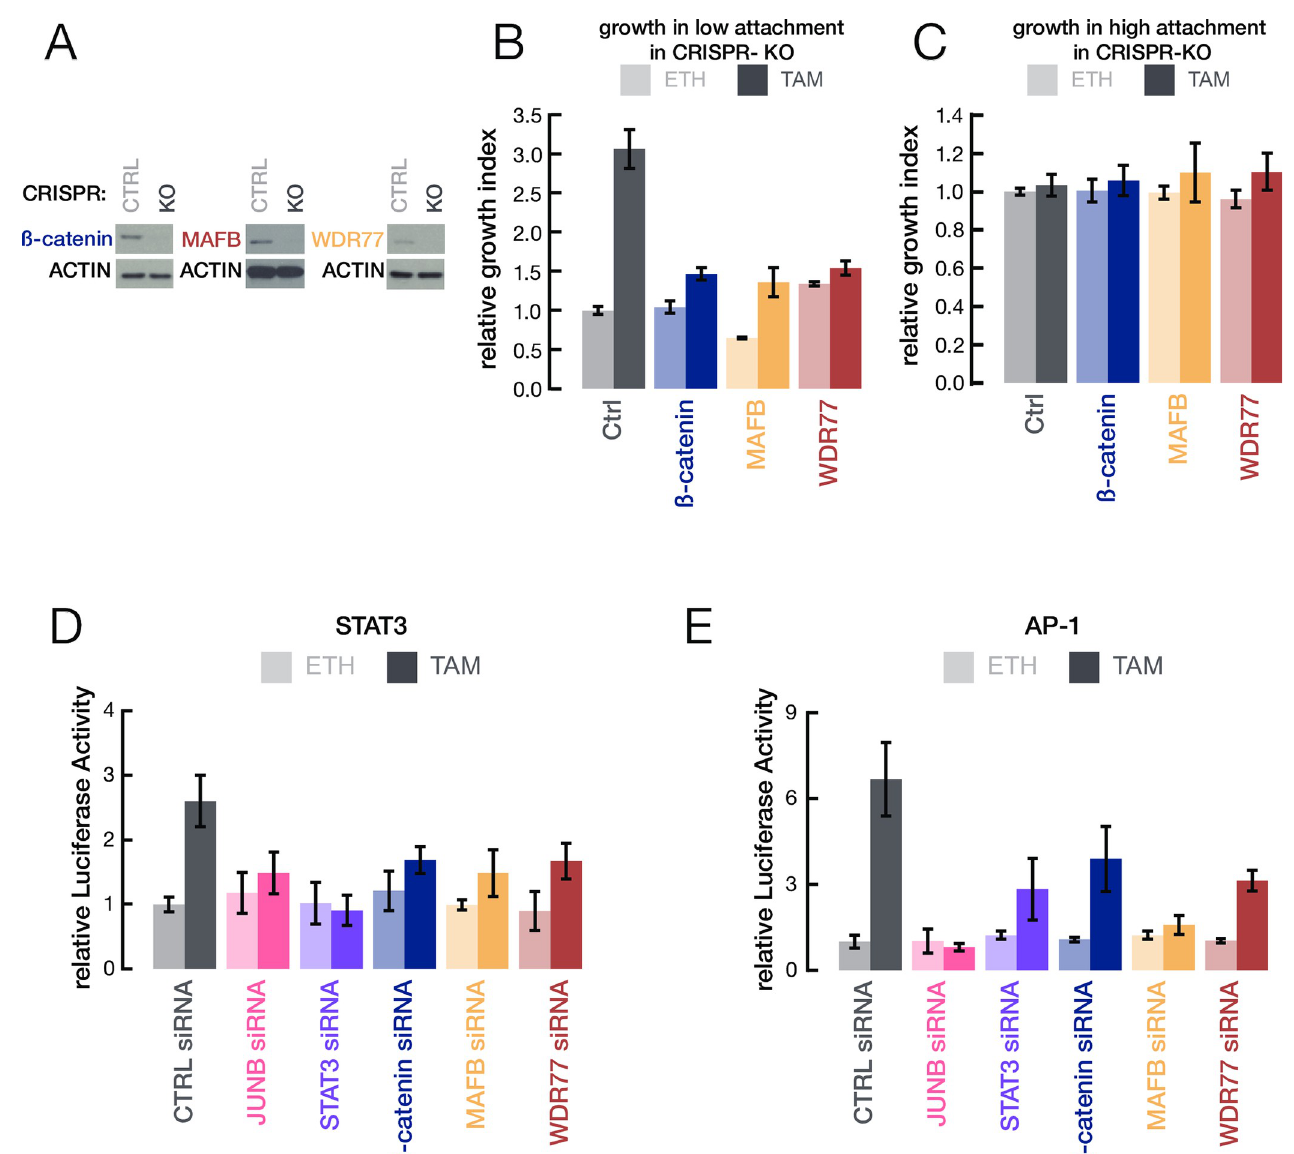
Fig 1. β -catenin, MafB, and WDR77 are important for transformation. (A) Western blots of β -catenin, MafB, and WDR77 in CRISPR knocked-out (CRISPR-KO) and CRISPR control cells (CRISPR-Ctrl). (B, C) Relative growth in low attachment (B) or normal (high-attachment)(C) conditions of transformed (tamoxifen treated; TAM shown in darker colors) and non-transformed (ethanol treated; ETH shown in lighter colors) cells with the indicated knockouts. (D, E) Relative STAT3 (D) or AP-1 (E) reporter (luciferase) activity in non-transformed and transformed cells upon the indicated siRNA knockdowns. Error bars indicated ± SD of 3